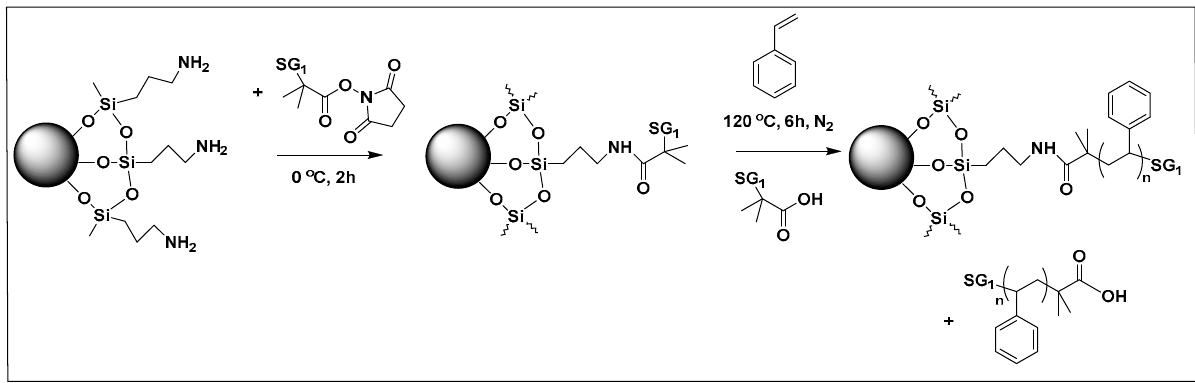
Figure 16. Scheme for anchoring of the MAMA-SG1 initiator and SI-NMP polymerization of styrene on the SiO 2 NP surface. Reproduced with permission from Ref. [32].